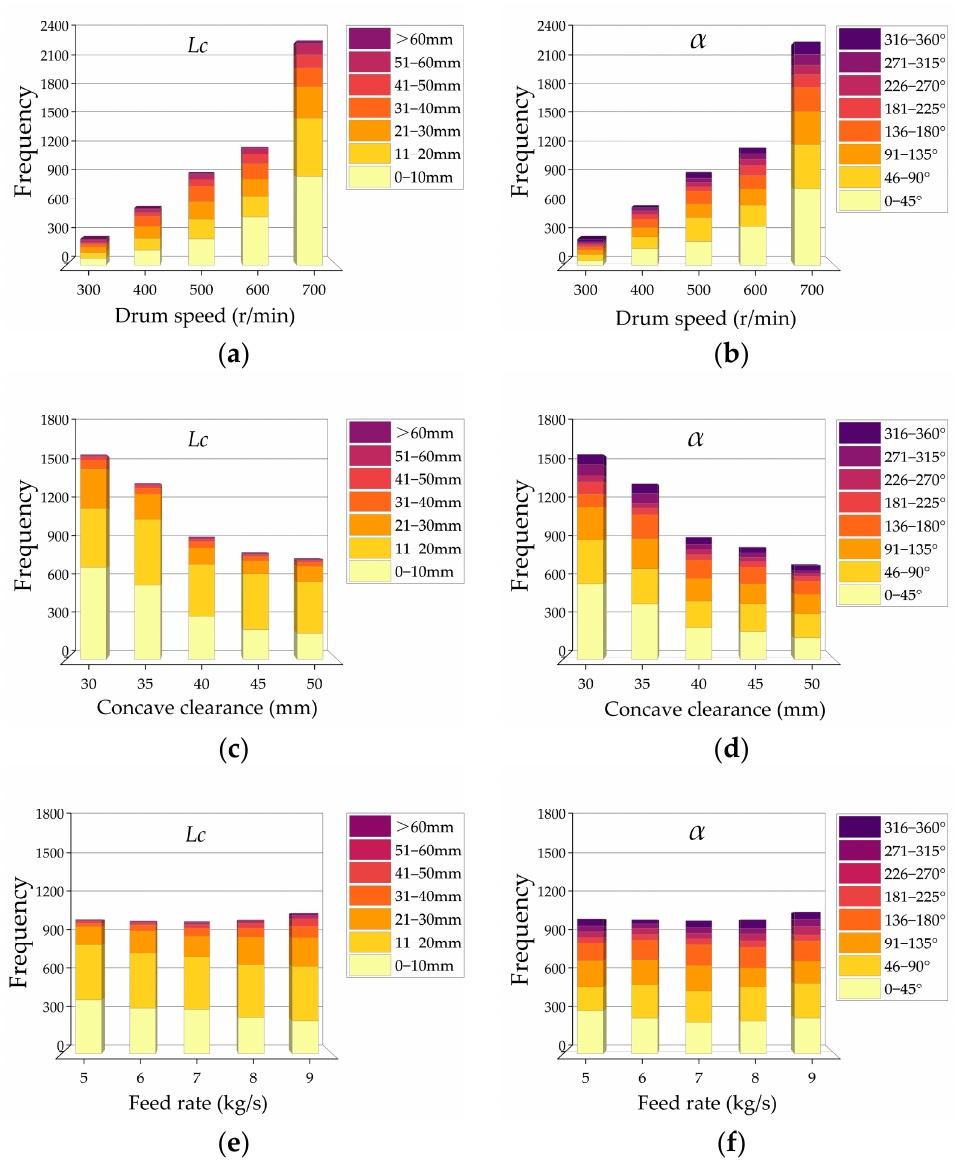
Figure 7. Particle size distribution of corn cobs. ( a , b ): L C and α of corn cobs for different drum speeds; ( c , d ): L C and α of corn cobs for different concave clearances; ( e , f ): L C and α of corn cobs for different feed rates.